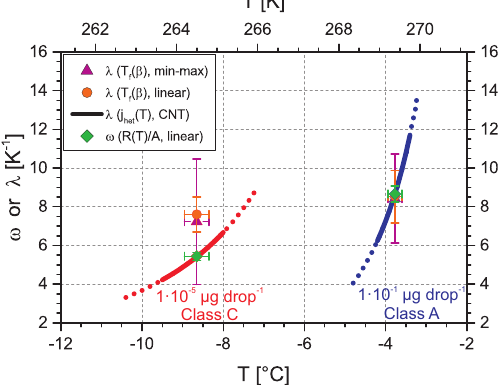
Figure 7. Value of ω and λ derived in different ways for the two in- dicated classes of Snomax ® INs. Magenta triangle: λ obtained from Eq. (9) at the minimal (0.1Kmin − 1 ) and maximal (10Kmin − 1 ) cooling rate. Orange circle: λ obtained from the linear fits to the T f , 50 data shown in Fig. 5. Green diamond: ω = − dln (R/A)/ d T obtained from a linear fit to the R(T )/A data shown in Fig. 6c. Lines indicate λ derived from the derivative of the nucleation rate coeffi- cient − dln (j het )/ d T based on CNT with a temperature-dependent contact angle; for details see